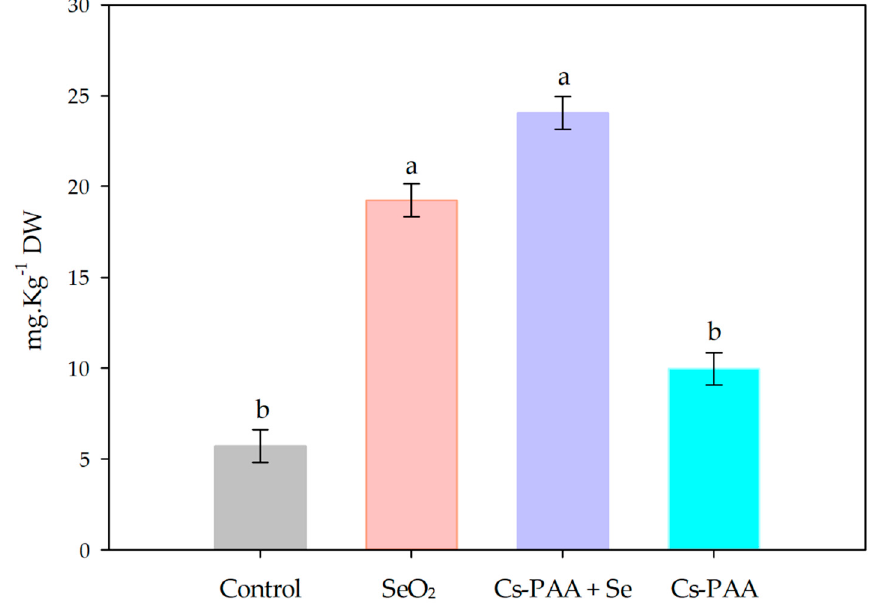
Figure 3. Mean values of the Se accumulation in lettuce plants. Means with the same letter are statistically equal (LSD, p ≤ 0.05). Bars represent standard error.